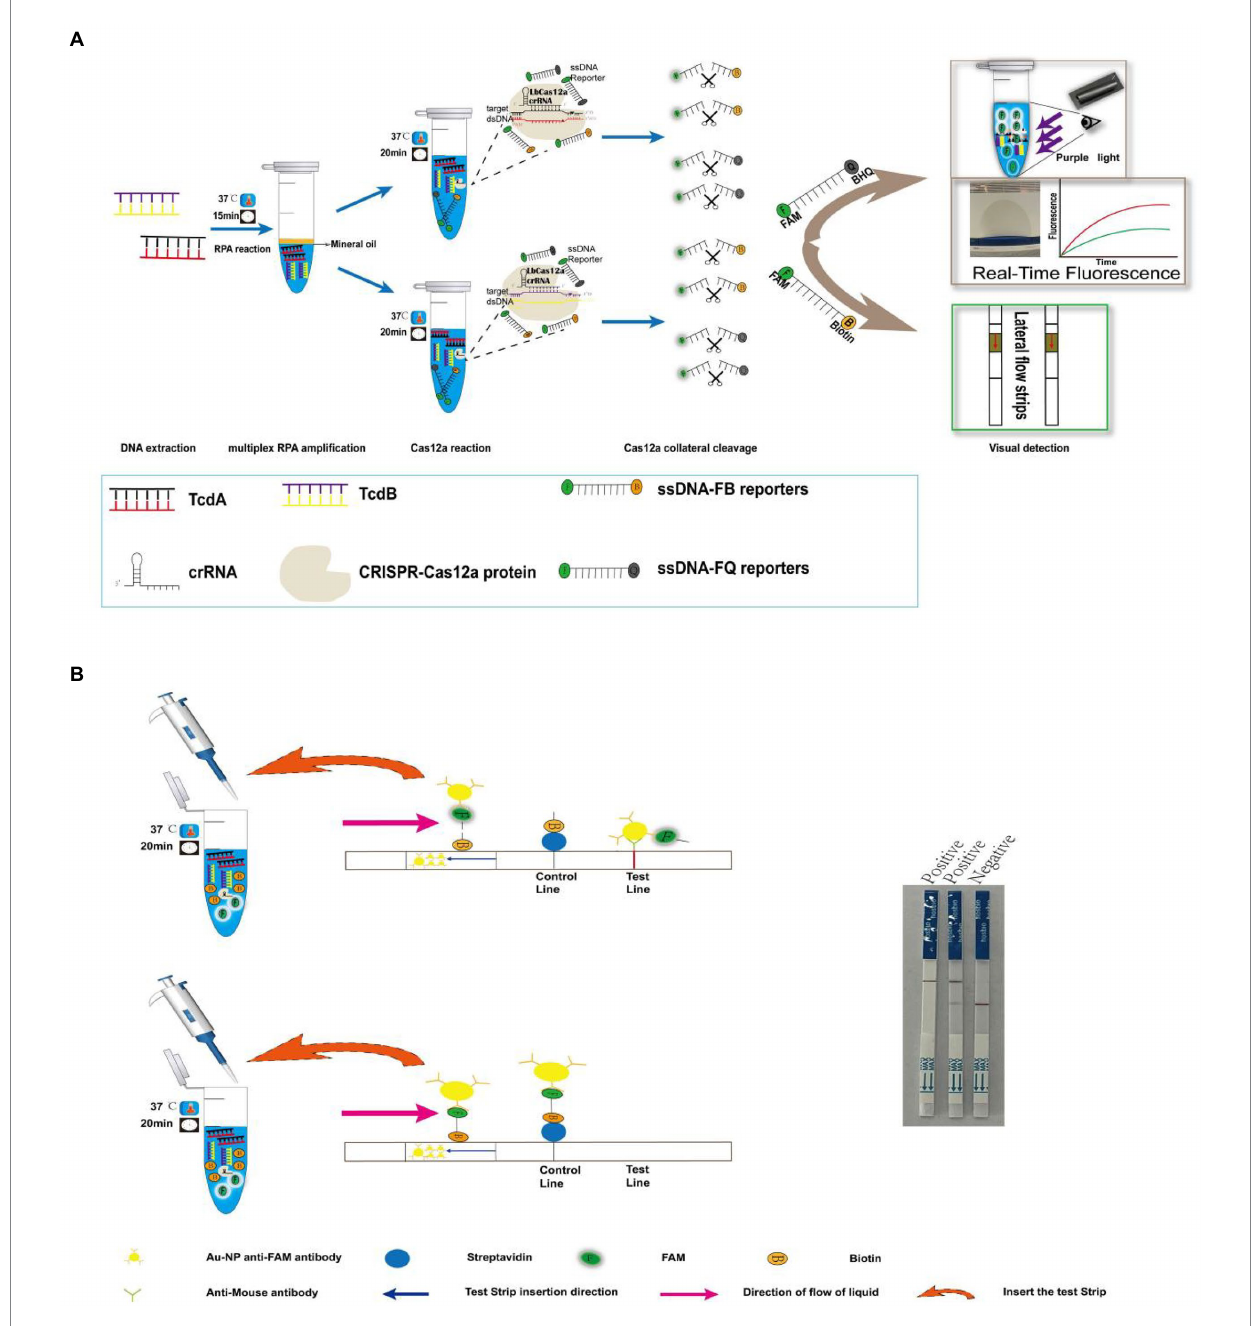
FIGURE 1 Multiplex RPA combined with Cas12a technology for C. difficile toxin gene detection strategy. (A) Schematic overview of the rapid detection of C. difficile dual toxin genes by multiplex RPA combined with Cas12a technology. (B) Schematic diagram of the principle of multiplex